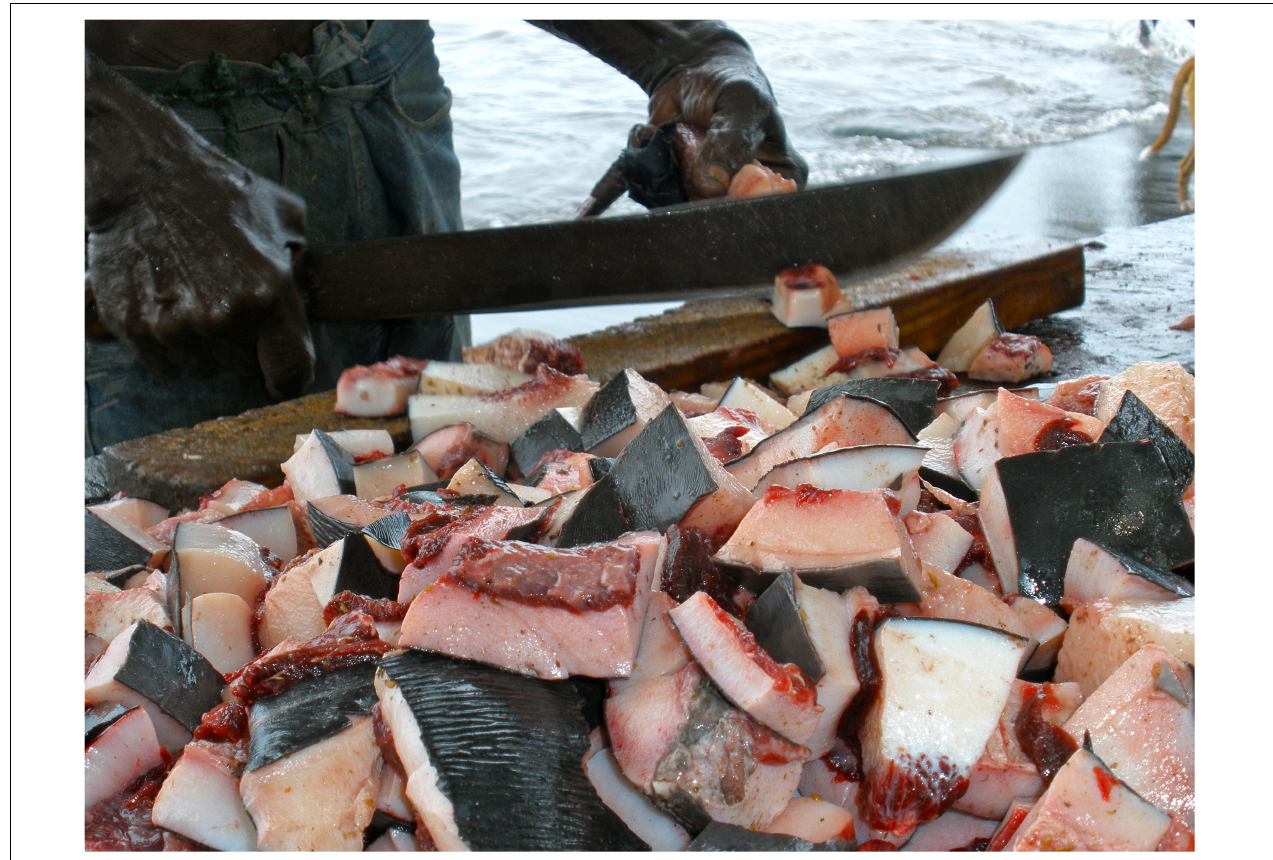
FIGURE 7 | Blubber from an unidentified small cetacean being prepared as “crisps” on the beach at Barrouallie. Photograph by Russell